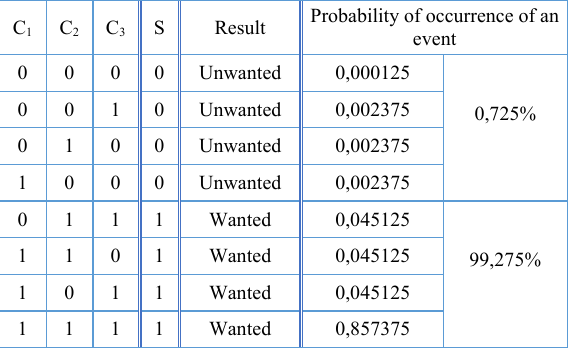
Table 2. Effect on the quality of a decision in the case of a subordinate headed by three chiefs. Probability of occurrence of an Result event